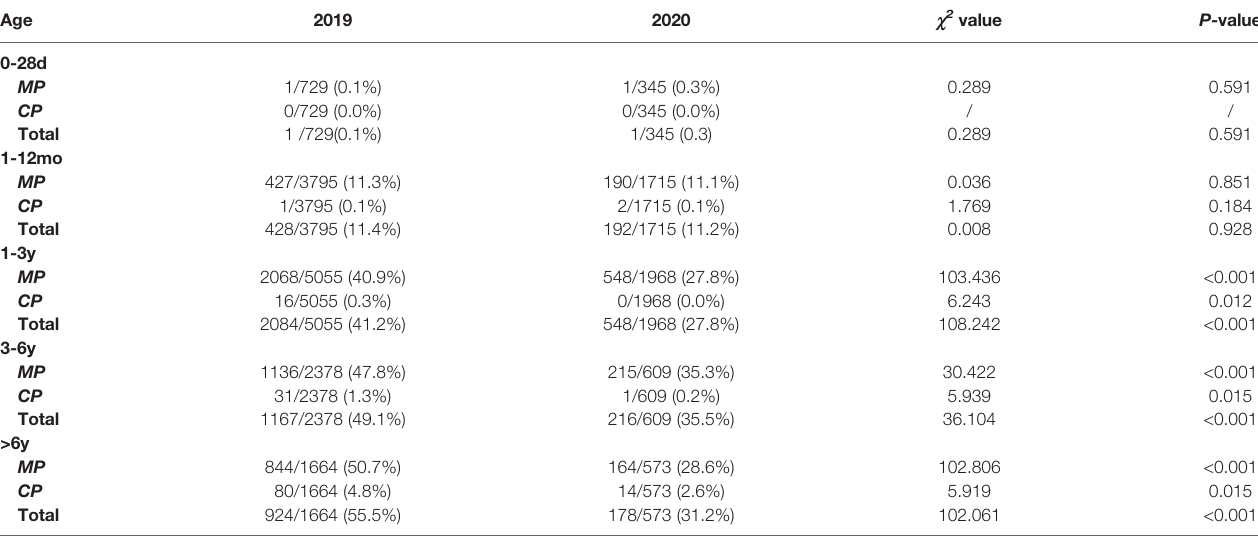
TABLE 2 | The overall positive rate of Mycoplasma pneumoniae and Chlamydia pneumoniae based on age between 2020 (during the COVID-19 pandemic) and 2019 (before the COVID-19 pandemic).